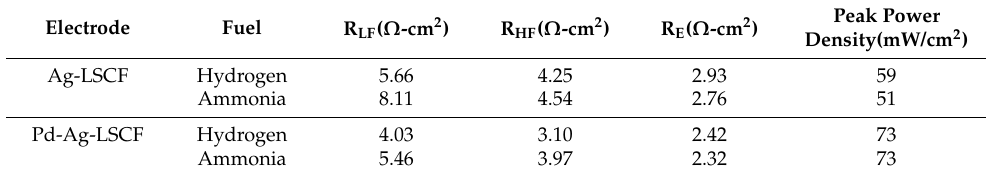
Figure 13. EIS for Pd-Ag-LSCF//YSZ//GDC/LSCF cell with hydrogen (hydrogen = 75 mL/min, air = 75 mL/min) and ammonia fuels (ammonia = 50 mL/min, air = 75 mL/min). Table 2. Results summarised for Ag-LSCF and Pd-Ag-LSCF